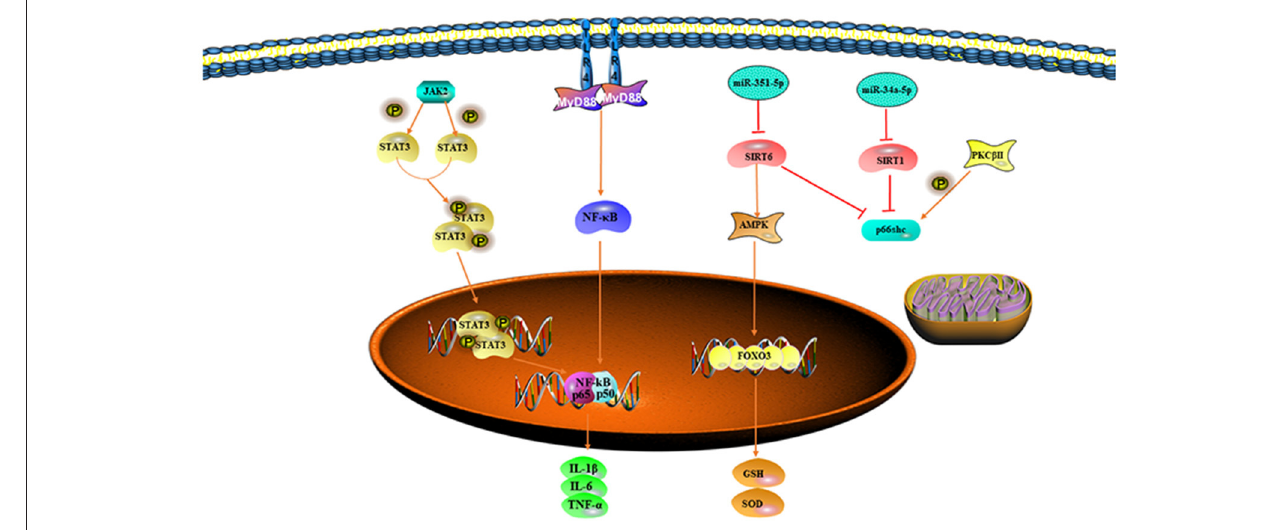
FIGURE 2 | Signal pathways that exacerbate oxidative